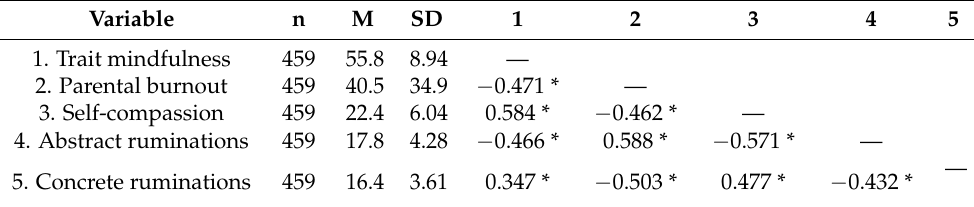
Table 1. Descriptive statistics and correlations (Pearson’s r) among the study variables at Time 1. Variable n M